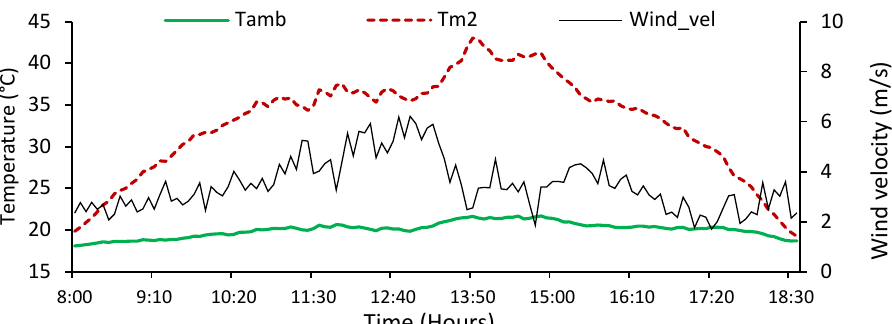
Figure 7. Measured ambient temperature, module temperature, and wind velocity.